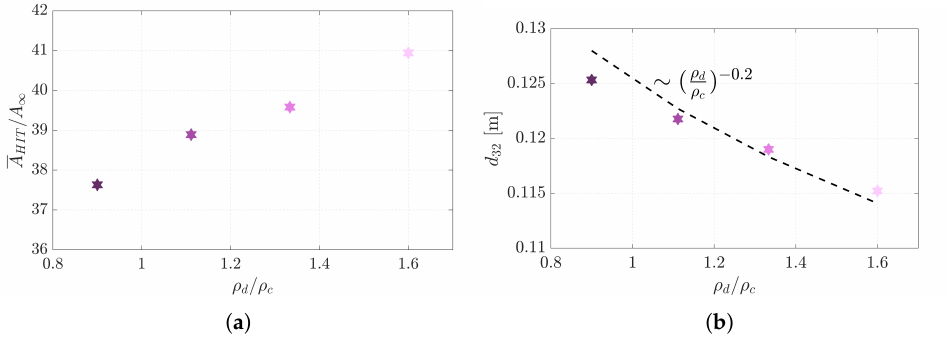
Figure 5. Evolution of ( a ) the normalized interface area A HIT / A ∞ , of the configurations over ρ d / ρ c , and ( b ) the SMD d 32 over the density ratio ρ d / ρ c , together with the scaling law ( ρ d / ρ c ) − 0.2 . The color code corrresponds to Figure 4, i.e., from dark to light color ρ d / ρ c =